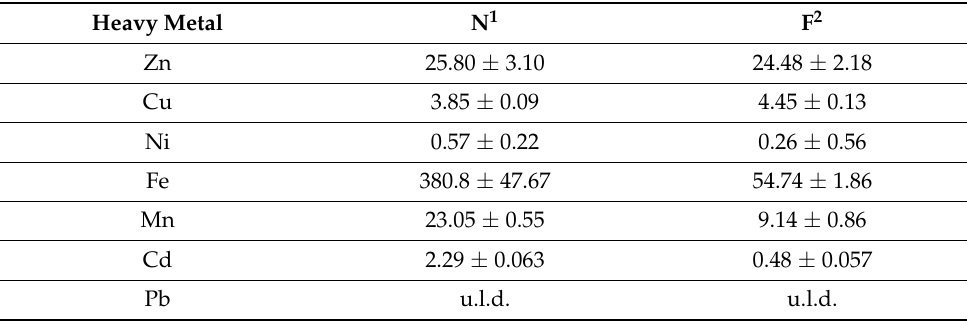
Table 2. The content of heavy metal in nettle and fenugreek in mg/kg (d.w.). Heavy